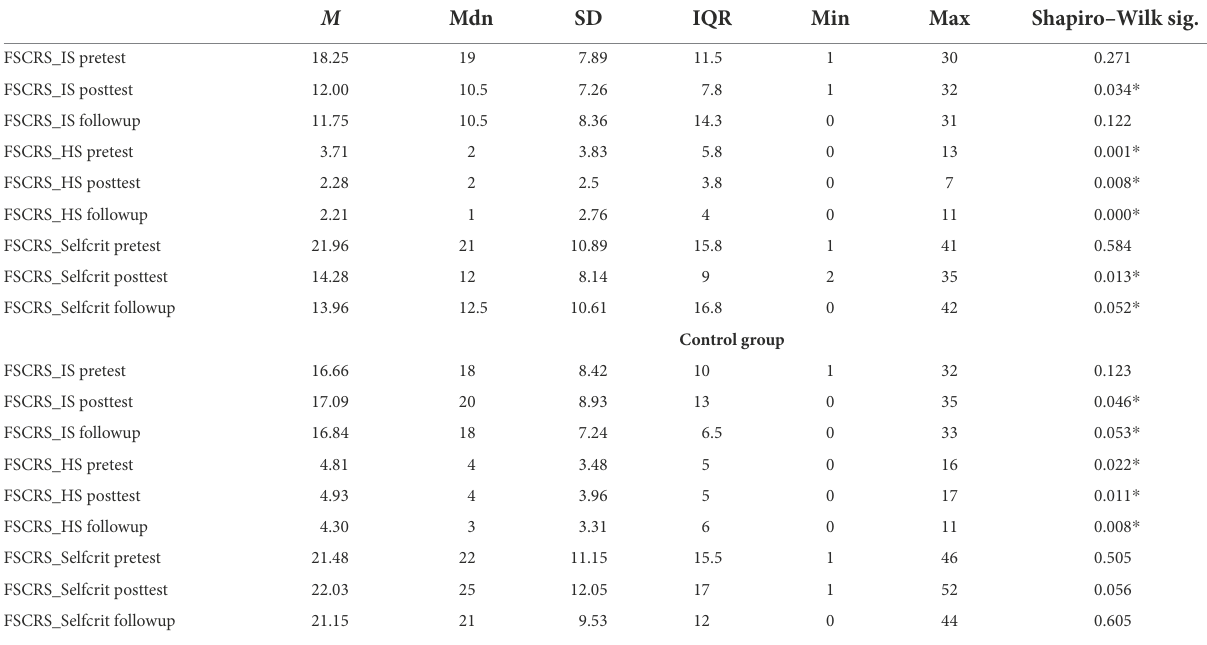
TABLE 4 Descriptive statistics for self-criticism and